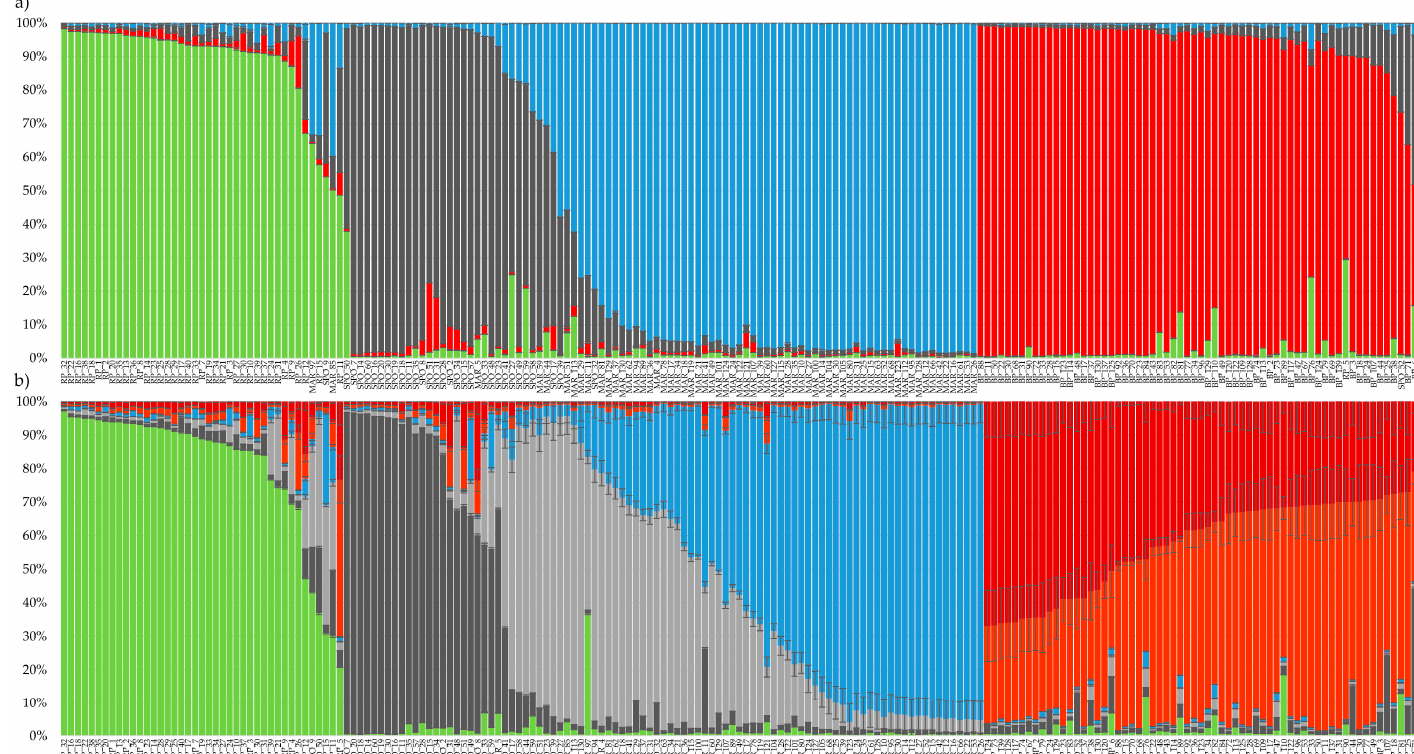
Figure 4. Population genetic structure of the four main corn landraces in Veneto (N = 197) as estimated by STRUCTURE using the SSR marker data set. Each sample is represented by a vertical histogram partitioned into K = 4 (panel a ) or K = 6 (panel b ) colored segments that represent the estimated membership. The proportion of ancestry (%) is reported on the ordinate axis and the identification number of each accession is reported below each histogram. The color scheme for the figure is the same as for the symbols and the text described in Figures 1 and 2, respectively. Green = Rosso Piave, black = Sponcio, blue = Marano and magenta = Biancoperla. For K = 6 two shades of red are used for the two clusters of Biancoperla and the third new cluster between Sponcio and Marano is marked in grey.